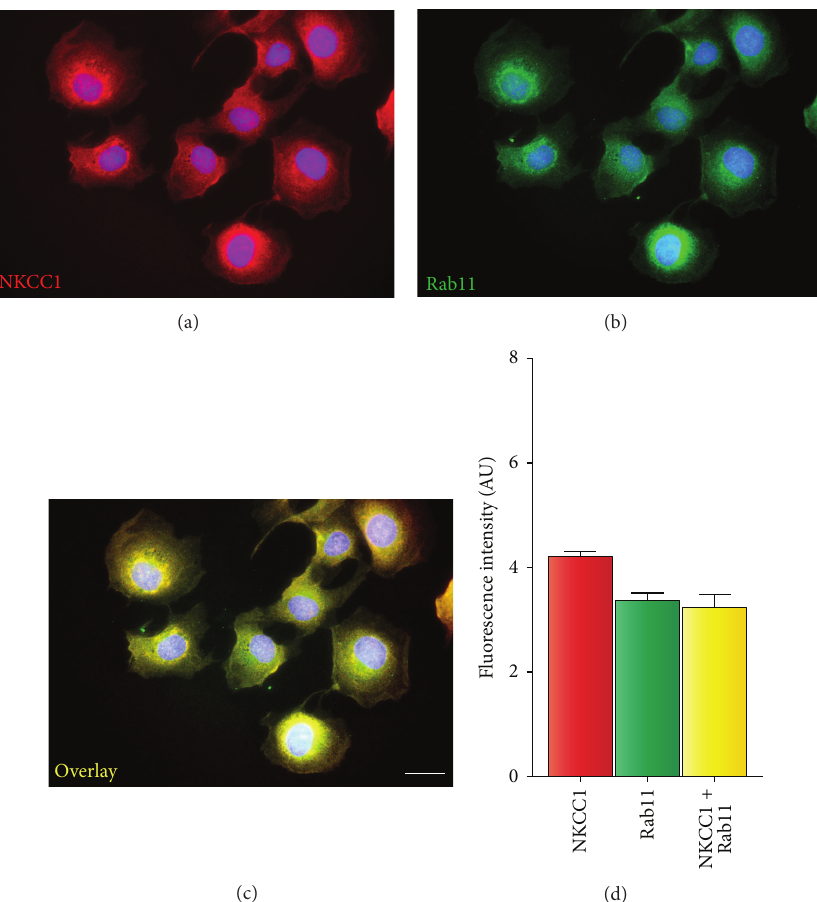
Figure 6: NKCC1 localizes in Rab11-positive compartments in COS7 cells. ((a)-(b)) Shown are representative images of COS7 cells expressing immunoreactive NKCC1 (a) or Rab11 (b). (c) (a) + (b) images superimposed to obtain an overlay image where colocalization could be estimated as yellow pixels (red + green). The scale bar represents 10 𝜇 m. (d) Semiquantitation of red (NKCC1), green (Rab11), and yellow (NKCC1 + Rab11) pixels. Shown are results obtained from at least 10 cells and represented as mean fluorescence intensity in arbitrary units ±